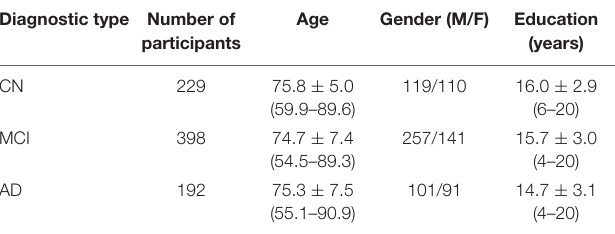
TABLE 1 | Demographic of participants with MCI and AD and cognitive normal subjects from the study population. Diagnostic type Number of